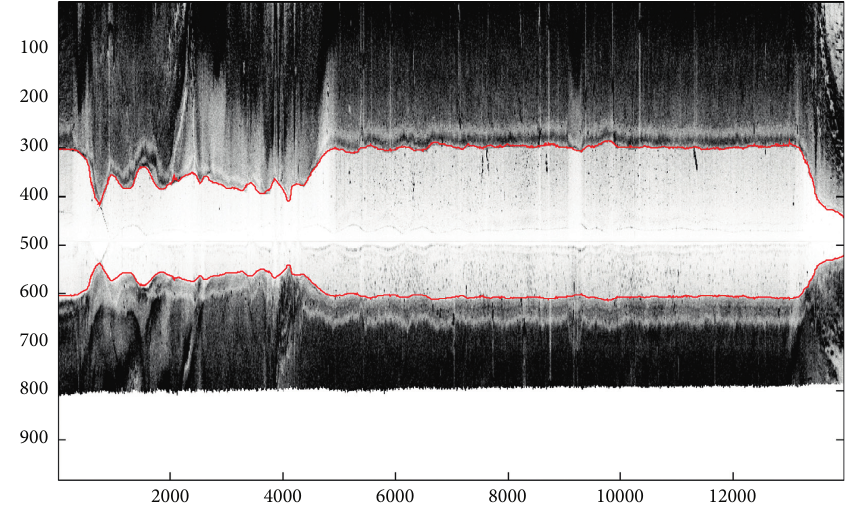
Figure 9: Sea bottom line marked in the waterfall of the SSS image without showing the blind